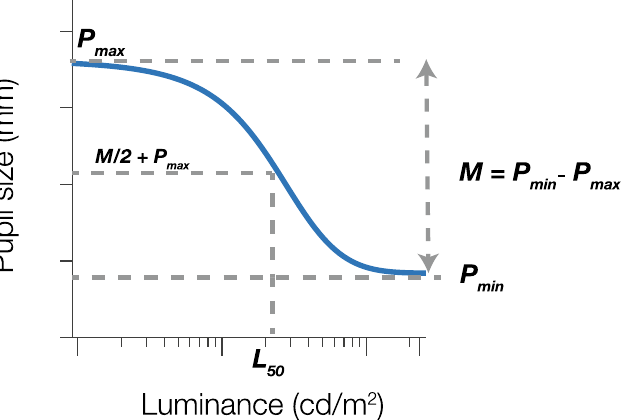
Figure 3. Illustration of the parameter estimates from the modified decrement Naka-Rushton function. Note that M is negative as it is a decrement